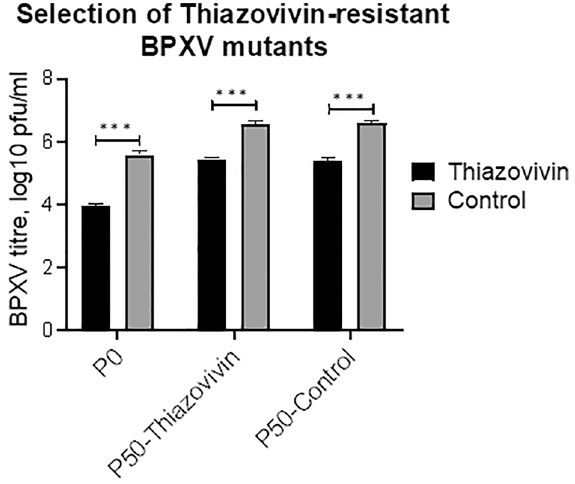
Figure 7. Evaluation of antiviral drug resistance against Thiazovivin. BPXV was sequentially passaged (P) fifty times in the medium containing 0.5 μg/ml of Thiazovivin or equivalent volumes of DMSO. The original virus stock (P0), P50-Thiazovivin and P50-Control viruses were used to infect Vero cells, in triplicates, at an MOI of 0.1 and treated with either 1 μg/ml of Thiazovivin or equivalent volumes of DMSO. The virus released in the supernatant at 48 hpi was quantified by plaque assay. Error bars indicate SD. Pair-wise statistical comparisons were performed using Student’s t test (***P < 0.001).